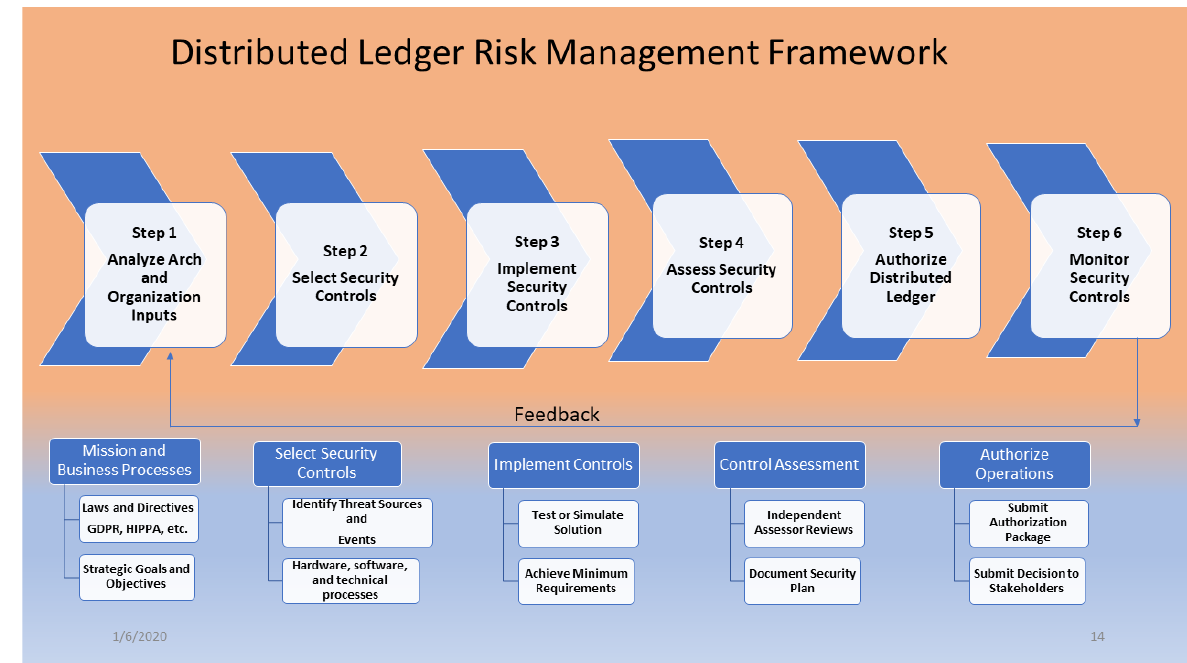
Figure 3. Distributed Ledger Risk Management